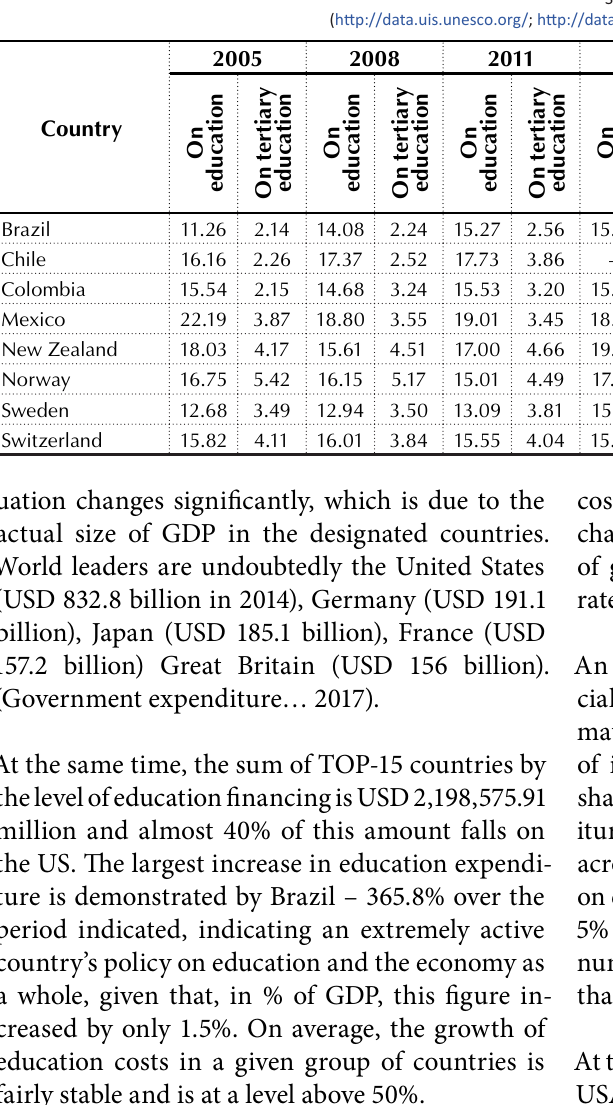
Table 4. Expenditure on education (and tertiary) as a share of total public expenditures (2005–2015),